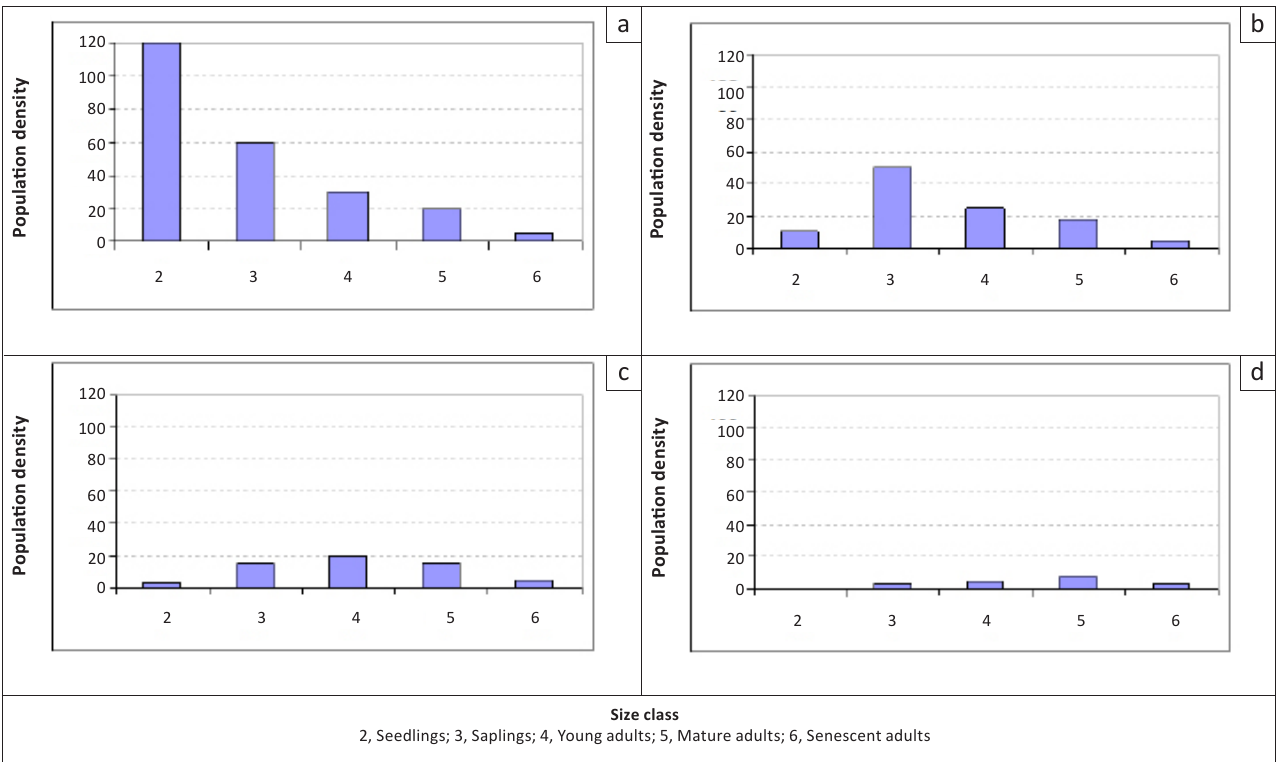
FIGURE 2: A hypothesis of the change over time in population size structure of non-germinant individuals of Breonadia salicina on bedrock-dominated channel